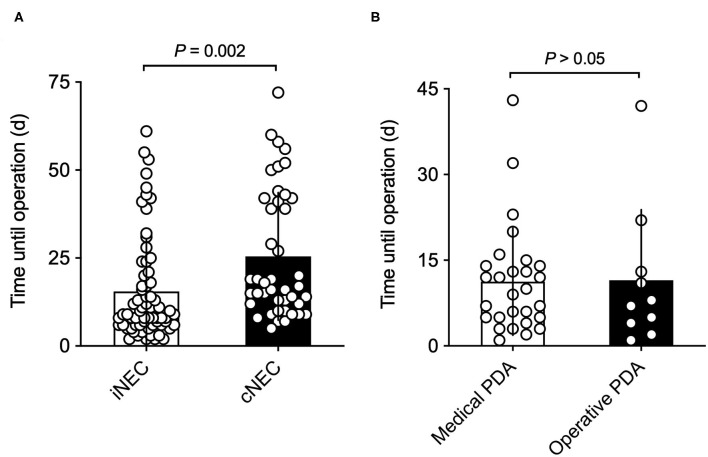
(A) Time from birth until NEC operation: neonates with retrospectively diagnosed iNEC were operated on significantly earlier than patients in the cNEC group. (B) Time from PDA closure until NEC operation: there are no differences between time of surgically confirmed NEC diagnosis and method of PDA closure. Risk of NEC manifestation is highest in the first 2 weeks of PDA closure.